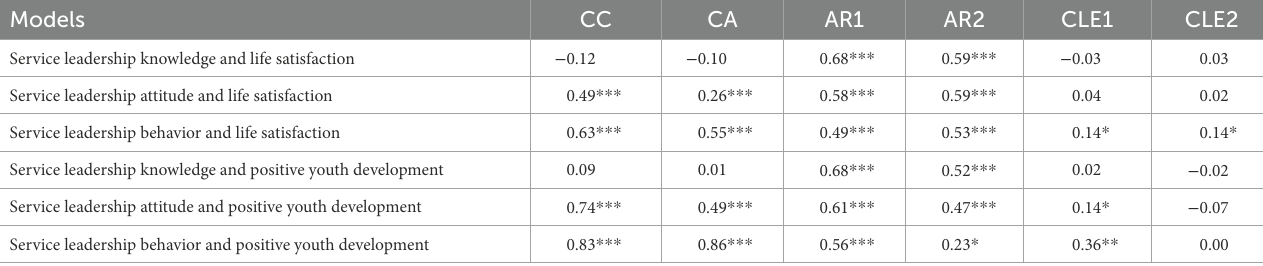
TABLE 3 Standardized path coefficients of cross-lagged path analyses ( N = 198). Models